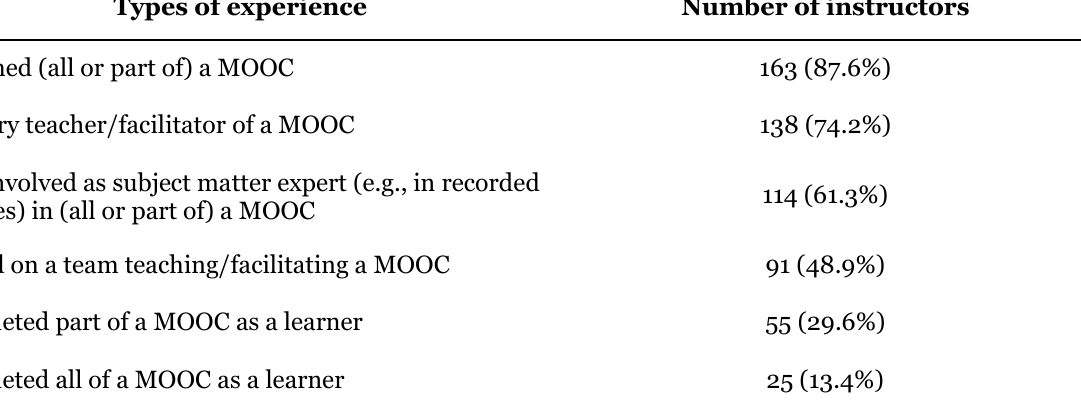
Experience With MOOCs Types of